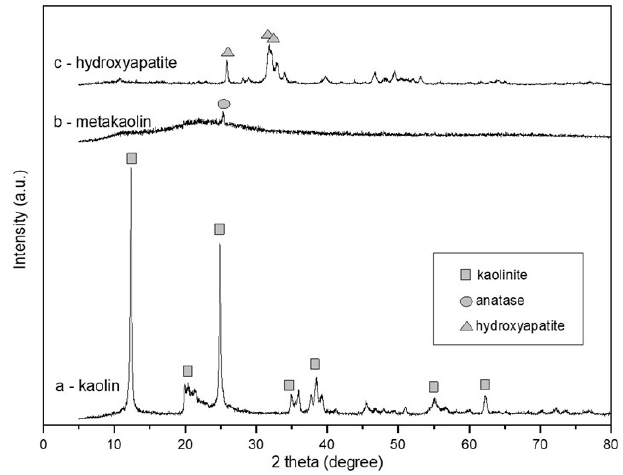
Figure 2. The XRD patterns of: ( a ) kaolin, ( b ) metakaolin, and ( c )